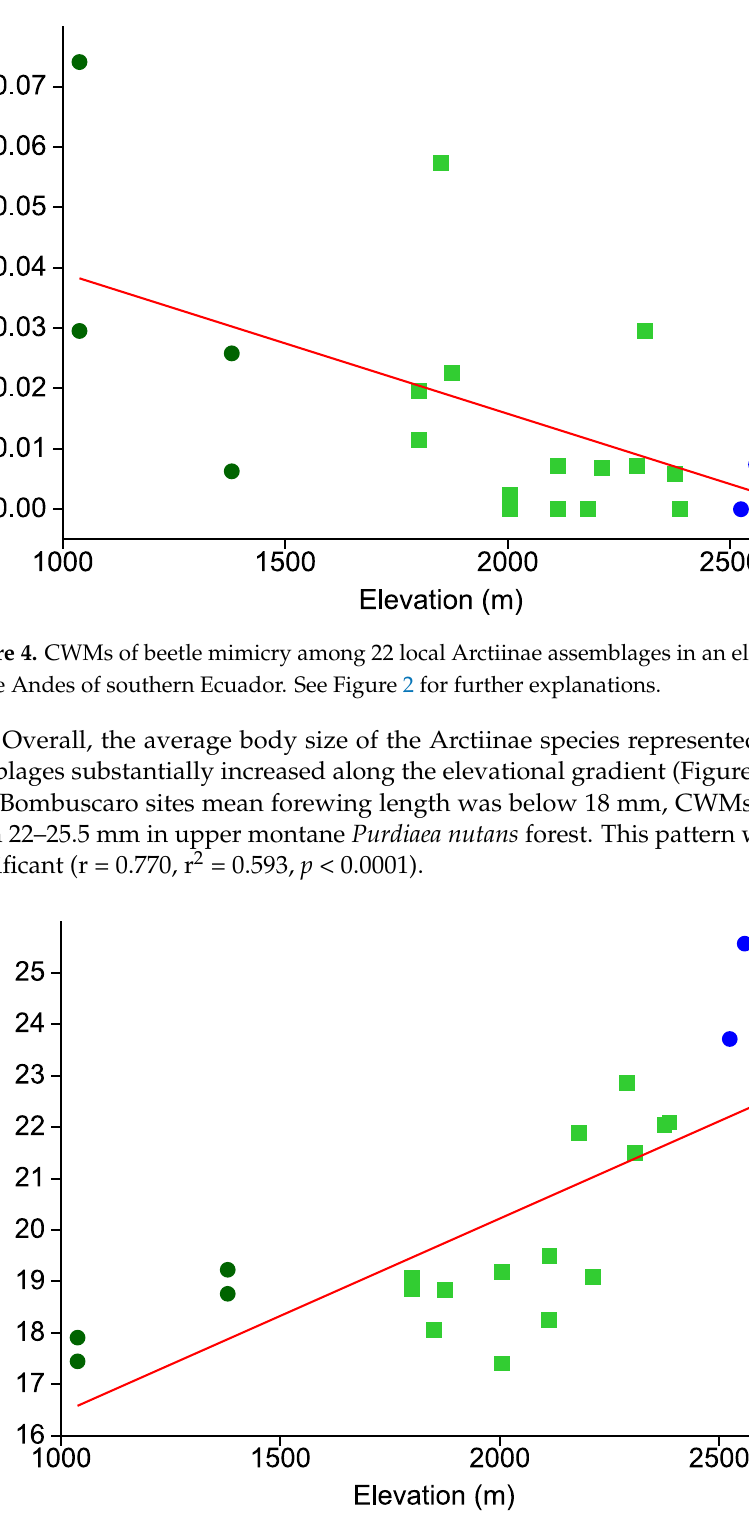
Figure 5. CWMs of forewing length (as a proxy of body size) among 22 local Arctiinae see Figure 2 for further explanations.